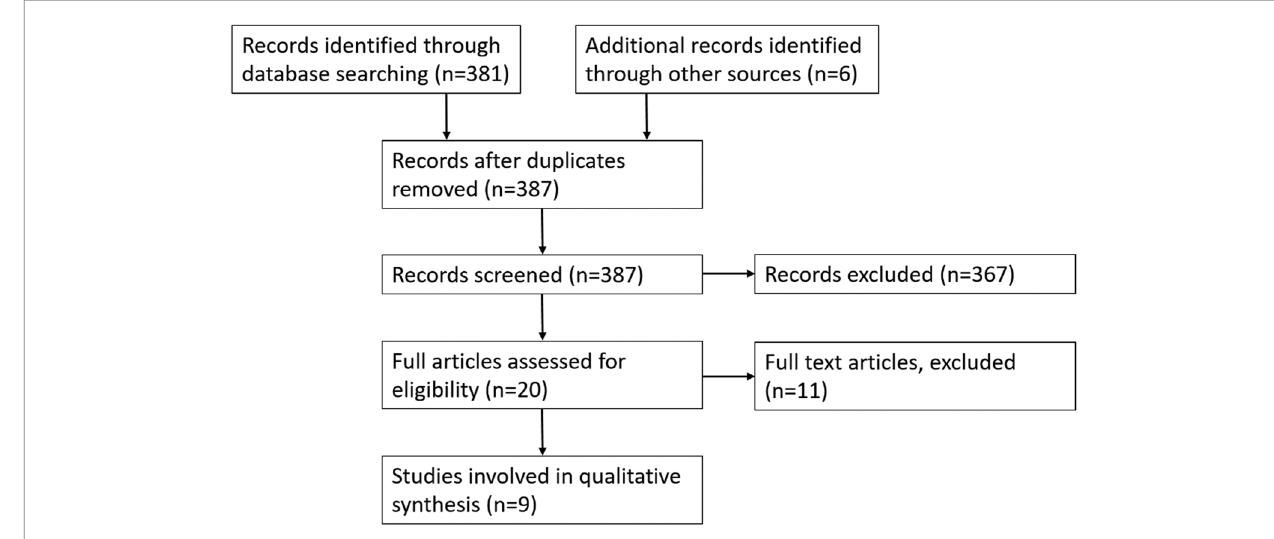
FIGURE 2 | Flow diagram of records involved in analysis of human scar